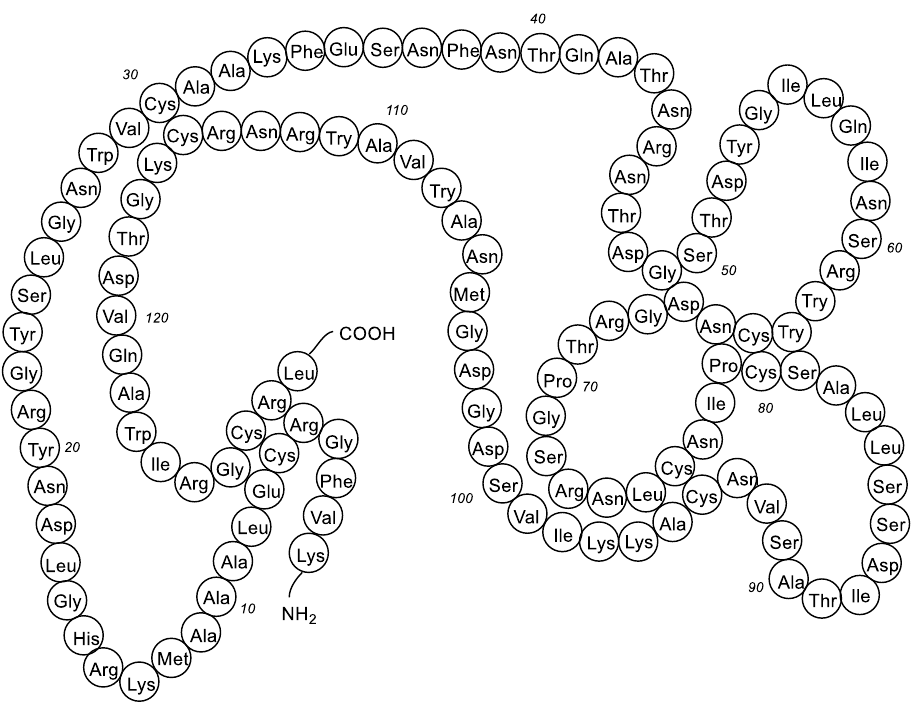
Figure 2. Structure of lysozyme (T. Wu et al. Food Chemistry 2019 , 274 , 698–709). Lysozymes are present not only in human organs, tissues, and secretion, but also in the organs and secretions of various vertebrates, invertebrates, bacteria, and plants. They are classified into three main families: chicken type (c-type), goose type (g-type) and invertebrate type (i-type) [3]; also known are the phage type, bacterial type, and plant type lysozymes [4–6]. The chicken (cLys) and human (hLys) lysozymes are c-type Lys. The cLys is composed of 129 amino acid residues (14.3 kDa), whereas hLys is composed of 130 amino acid residues (14.7 kDa). There is a 59% identity between the sequence of human and chicken lysozymes but the antibacterial activity of hLys is three-fold greater than the antibacterial activity of